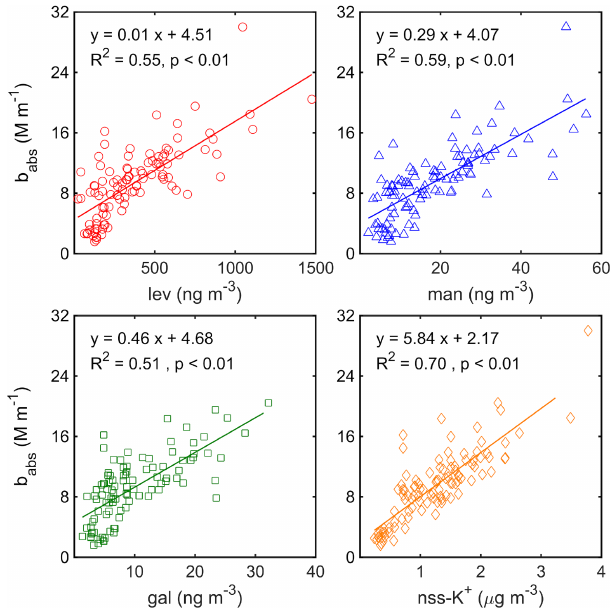
Figure 9. Correlations of water-soluble BrC carbon absorption co- efficient ( b abs ) vs. levoglucosan (lev), mannosan (man), galactosan (gal) and non-sea-salt potassium (nss-K + ) in PM 2 . 5 from 14 to 29 January 2015 in Nanjing.